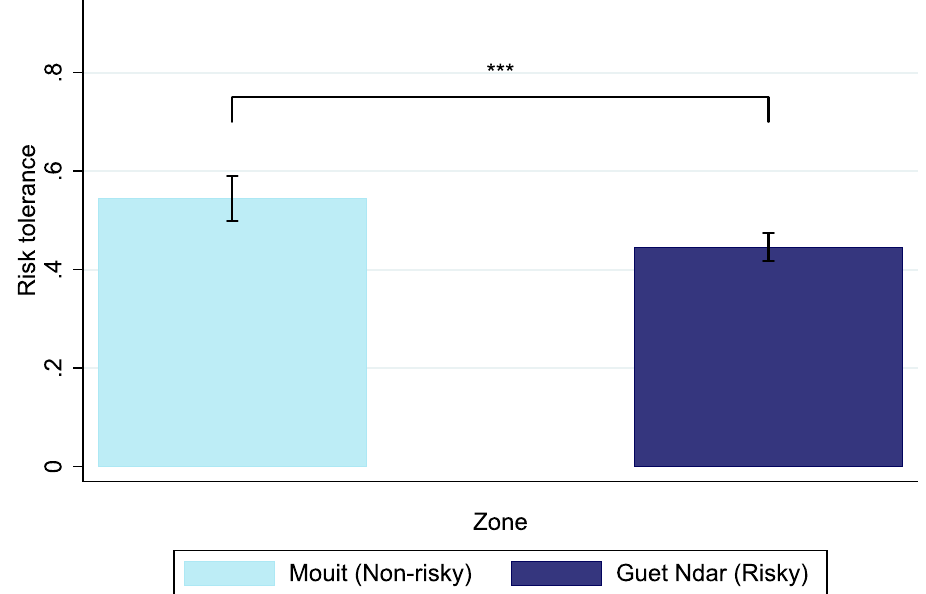
Figure 1. Average level of risk-tolerance by zone. Note: This figure shows the average level of risk-tolerance between the risky and non-risky areas. A higher level of risk-tolerance indicates the choice of a riskier lottery by participants in the lottery choice task. Segments represent 95% confidence intervals. Student’s t -test * p < 0.1, ** p < 0.05, *** p <